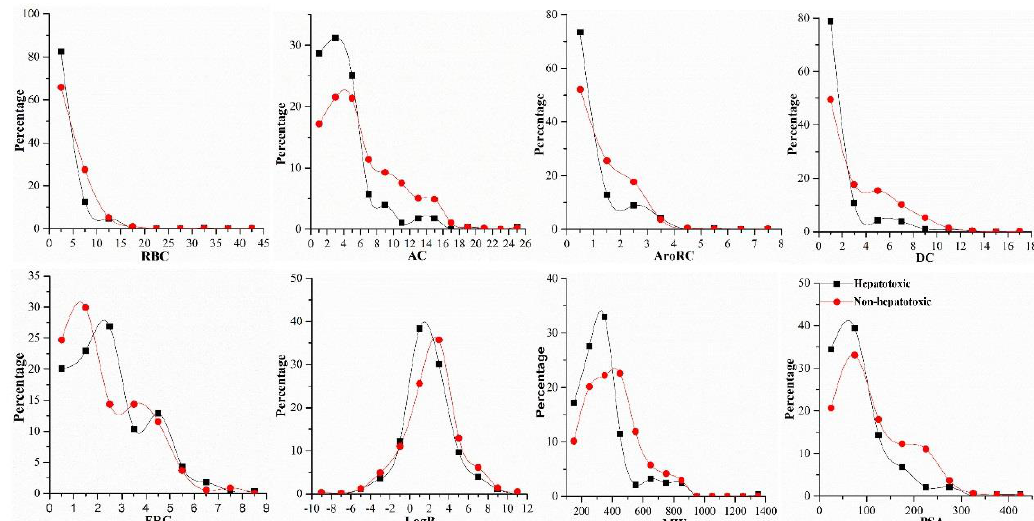
Figure 3. Comparing the chemical properties of hepatotoxic ingredients and non-hepatotoxic ingredients. RBC: the number of rotatable bonds; AC: the number of molecular hydrogen bond acceptor; AroRC: the number of aromatic rings; DC: the number of molecular hydrogen bond donor; FRC: the number of fused rings; LogP: the octanol/water partition coefficient; MW: molecular weight; PSA: the polar surface area.